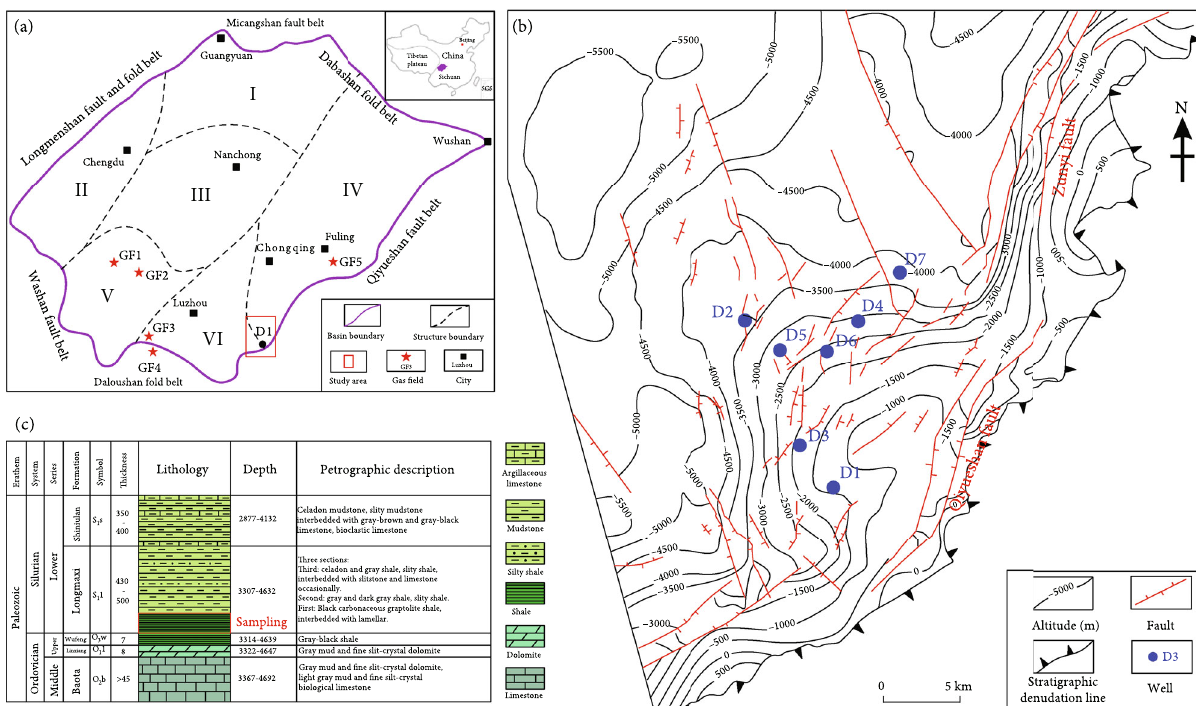
Figure 1: (a) Tectonic distribution of Sichuan Basin (I: low gentle tectonic of North Sichuan; II: low steep tectonic of West Sichuan; III: gentle tectonic of Middle Sichuan; IV: high steep tectonic of East Sichuan; V: low steep tectonic of Southwest Sichuan; VI: low steep tectonic of South Sichuan; GF1: Weirong gas fi eld; GF2: Weiyuan gas fi eld; GF3: Changning gas fi eld; GF4: Zhaotong gas fi eld; GF5: Fuling gas fi eld). (b) Buried depth map and sampling location of Longmaxi shales in Dingshan fi eld. (c) The formations and sampling target (according to Lu et al. [42] and Zhu [43] modi fi